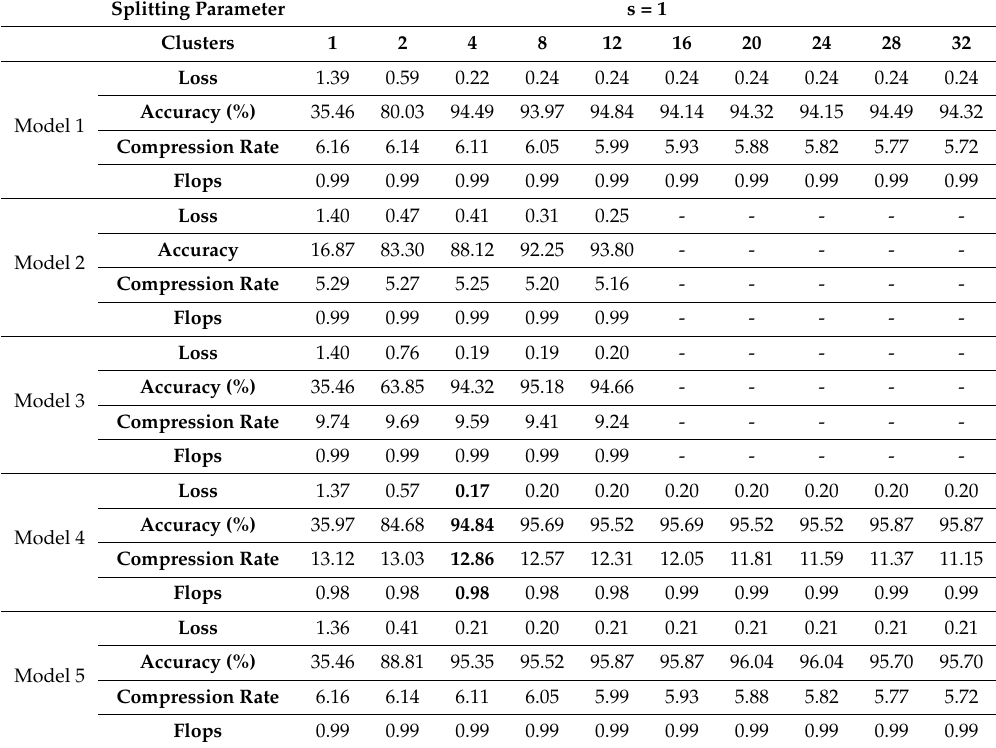
Table 11. Product quantization for all combinations of clusters and s = 1 on fully connected layer only. Splitting Parameter s = 1 Clusters